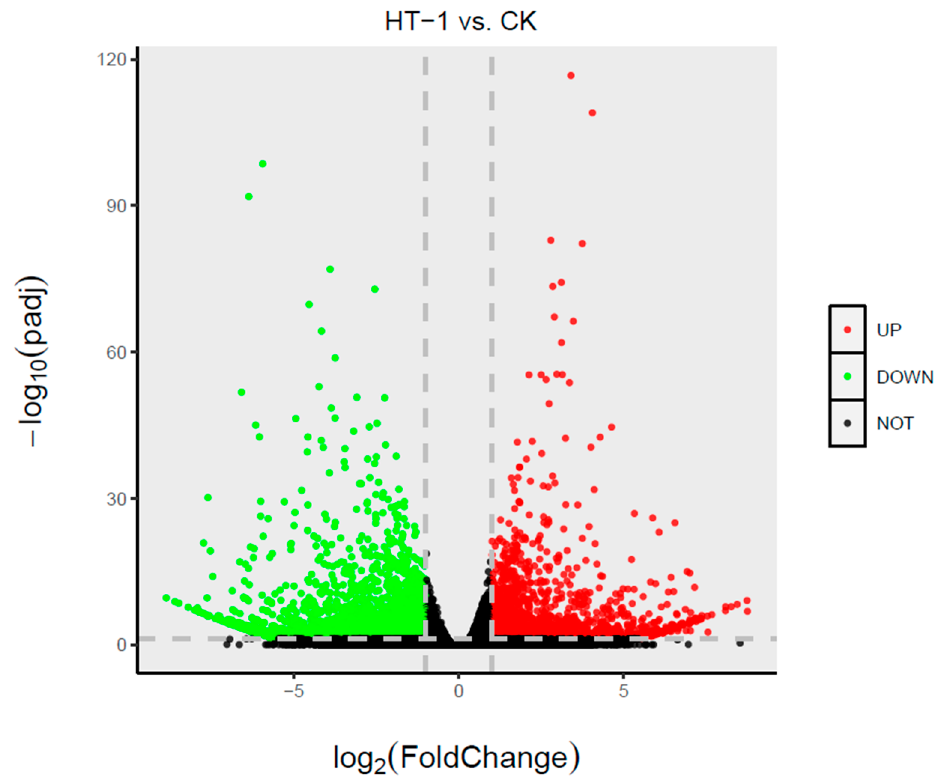
Figure 5. Volcano plots of differentially expressed genes. HT-1, R. palmatum roots from group the treated by 10 7 spores/mL HT-1 strain; CK, R. palmatum roots from the control group.